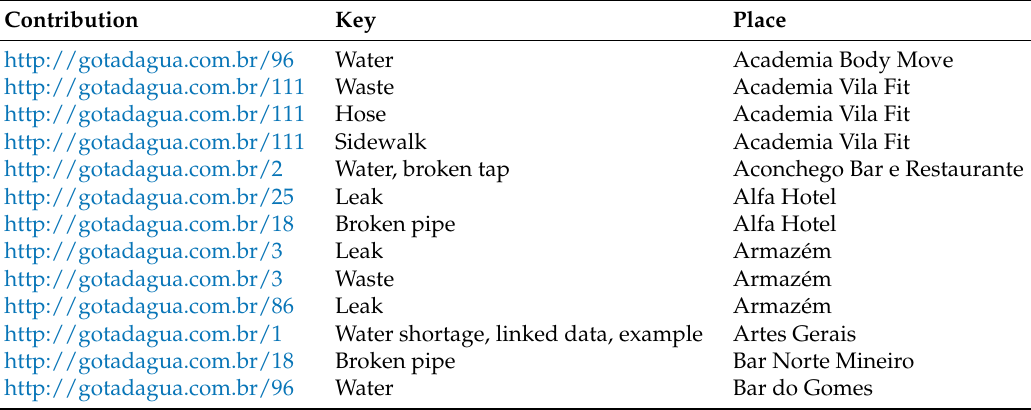
Table 2. Sample of tuples returned by query Q1.